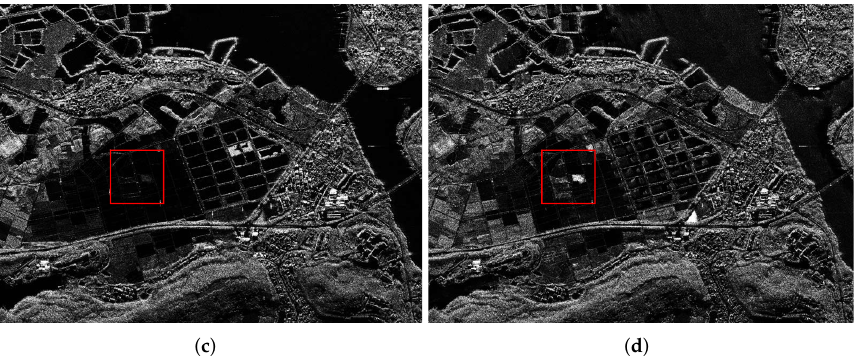
Figure 12. Intensity image of L-band airborne HCP data in Boao, Hainan province, China. ( a ) HR image. ( b ) VR image.